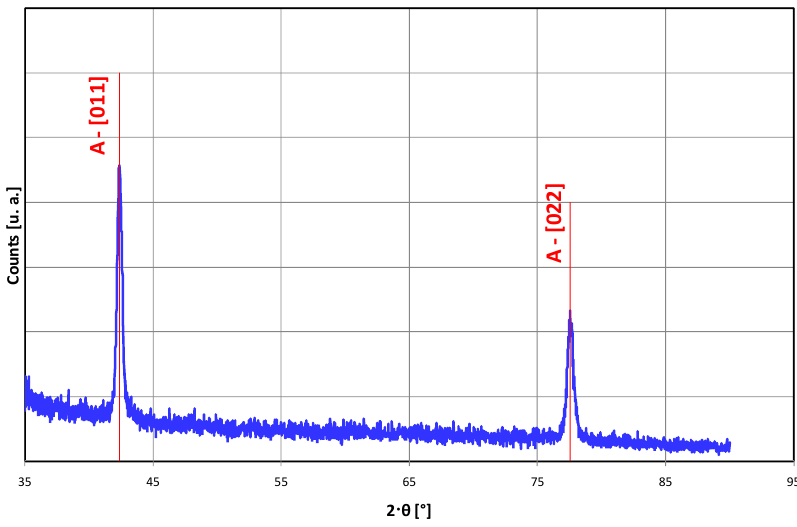
Figure 8: X-Ray spectra of the investigated NiTi alloy in stress free